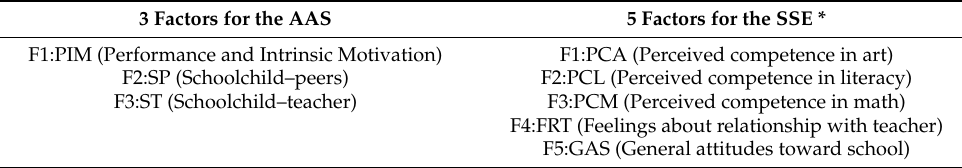
Table 3. Description of the factorial structures of the AAS and French FAS (i.e., SSE)